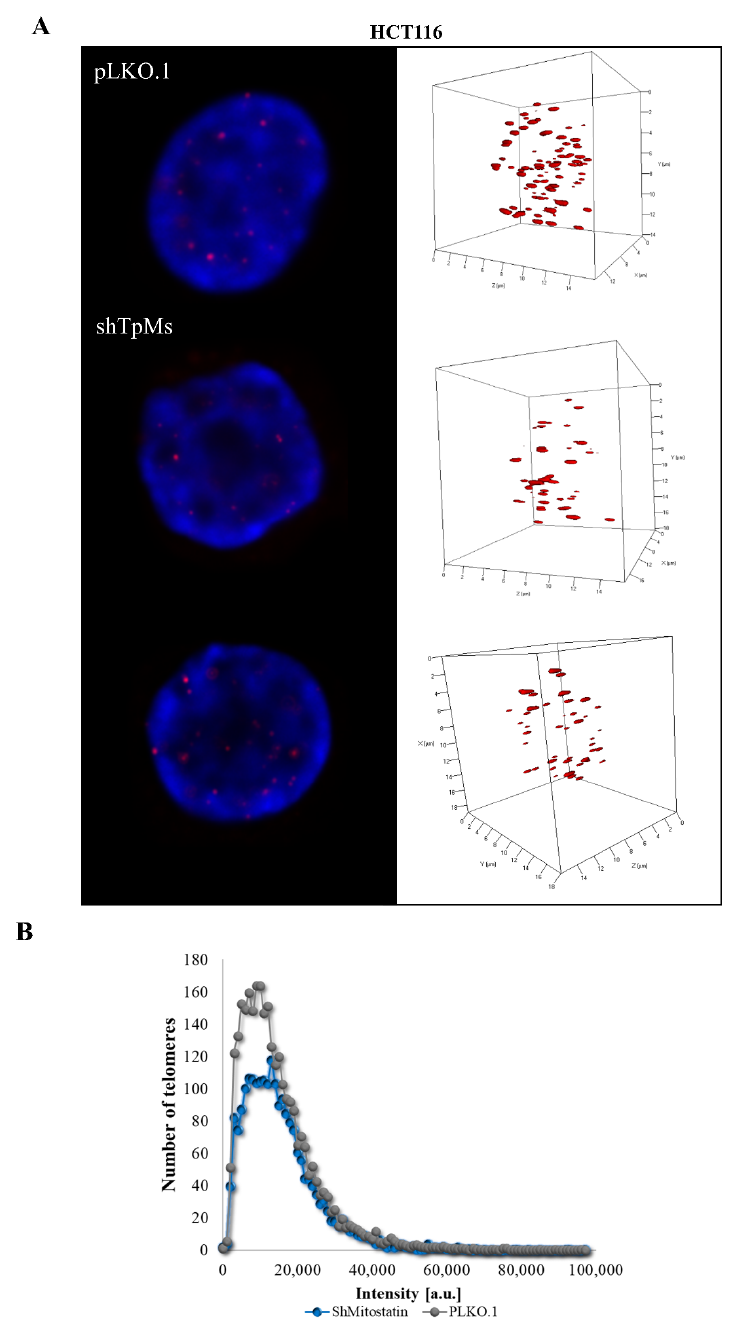
Figure 2. The number of telomere signals and aggregates decreases in TpMs-depleted HCT116 cells. ( A ) Representative nuclei, counterstained with DAPI (4 (cid:48) ,6-diamidino-2-phenylindole) (blue), where Cy-3 labelled telomeres appear as red dots. TpMs-depleted HCT116 cells show a decreased number of telomere signals and aggregates (middle and bottom rows) compared with control cells, pLKO.1 (top row). ( B ) A telomere intensity histogram showing distribution of signal intensities in HCT116 cells depleted of TpMs with respect to the control. [a.u.] = arbitrary units. Abscissa = intensity [a.u]. ordinate = number of telomere